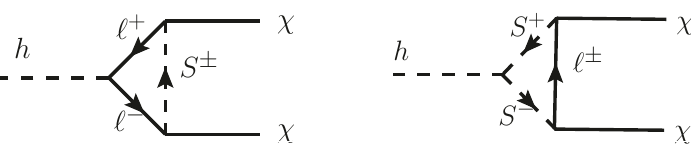
Figure 6 . The one-loop induced Higgs invisible decay. The cross-diagrams for Majorana fermion χ are not shown here, but are included in the